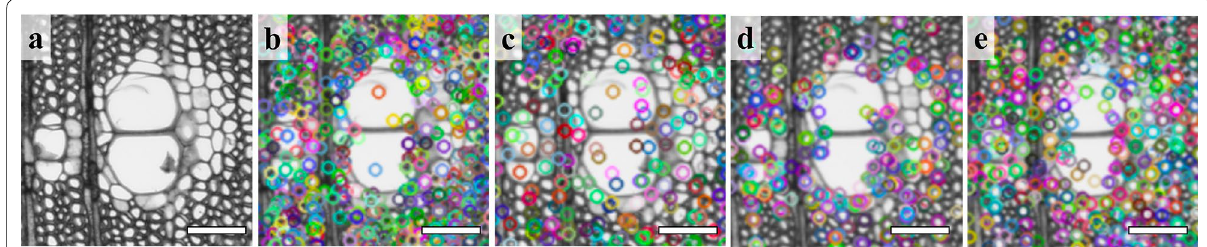
Fig. 2 Cross‑sectional image of Cinnamomum camphora ( a ) and keypoints in the image detected by SIFT ( b ), SURF ( c ), ORB (15,000) ( d ), and AKAZE ( e ). SIFT, SURF, ORB, and AKAZE detected 27,950, 15,159, 14,998, and 12,644 keypoints per image, respectively. The images are cropped regions of the original images. Circles in the figures indicate the location of keypoints detected by each algorithm ( b – e ), and their colors are randomly generated. Scale bars 100 μm